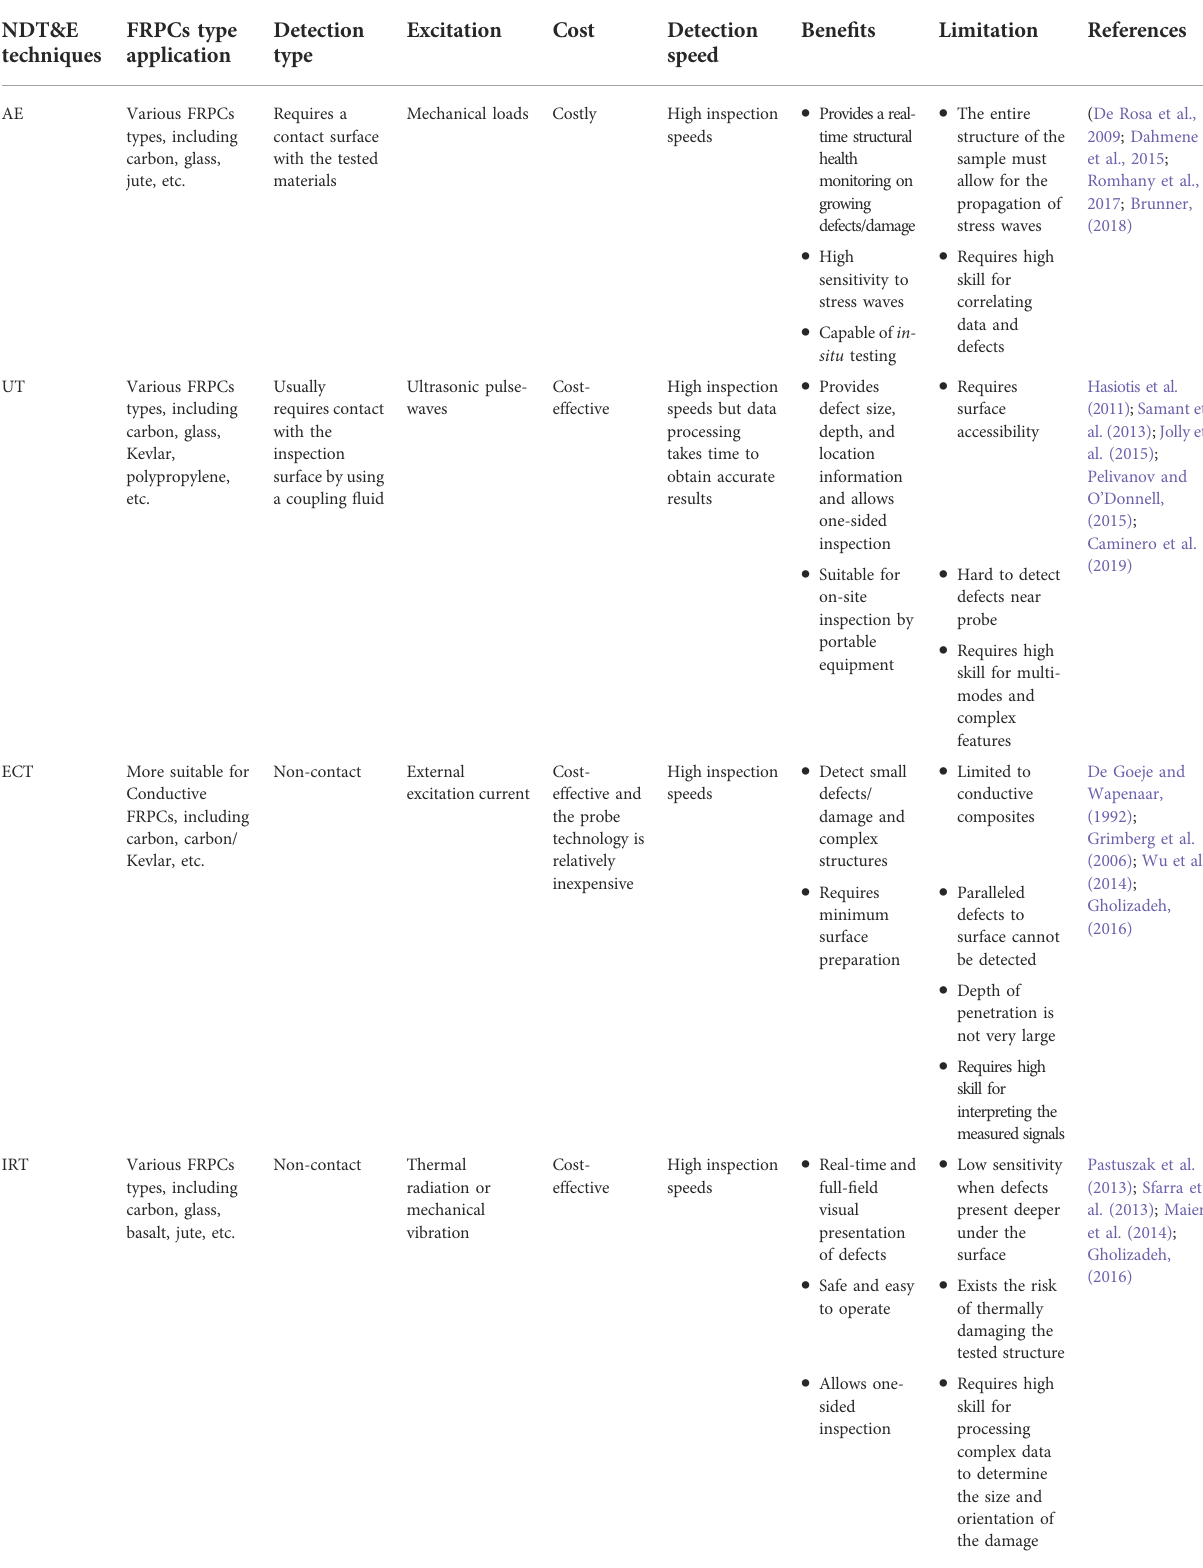
TABLE 3 Summary of the characteristics of established NDT&E techniques reviewed in this